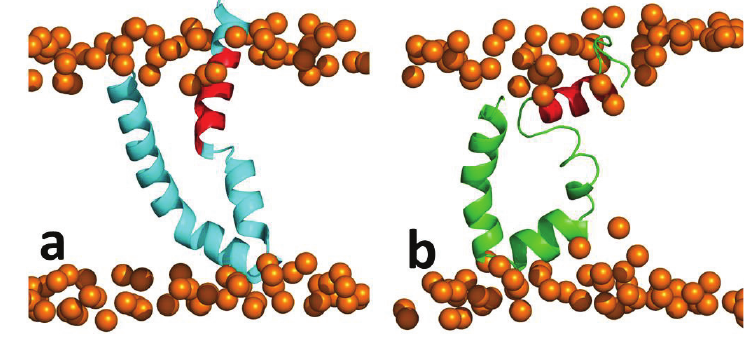
Supplementary Figure 1. Molecular dynamic simulation of I-Tasser model. ( a ) Initial starting (cyan) and ( b ) 100 ns snapshots (green) of molecular dynamic simulations. Segment residues 689–703 are colored in red.